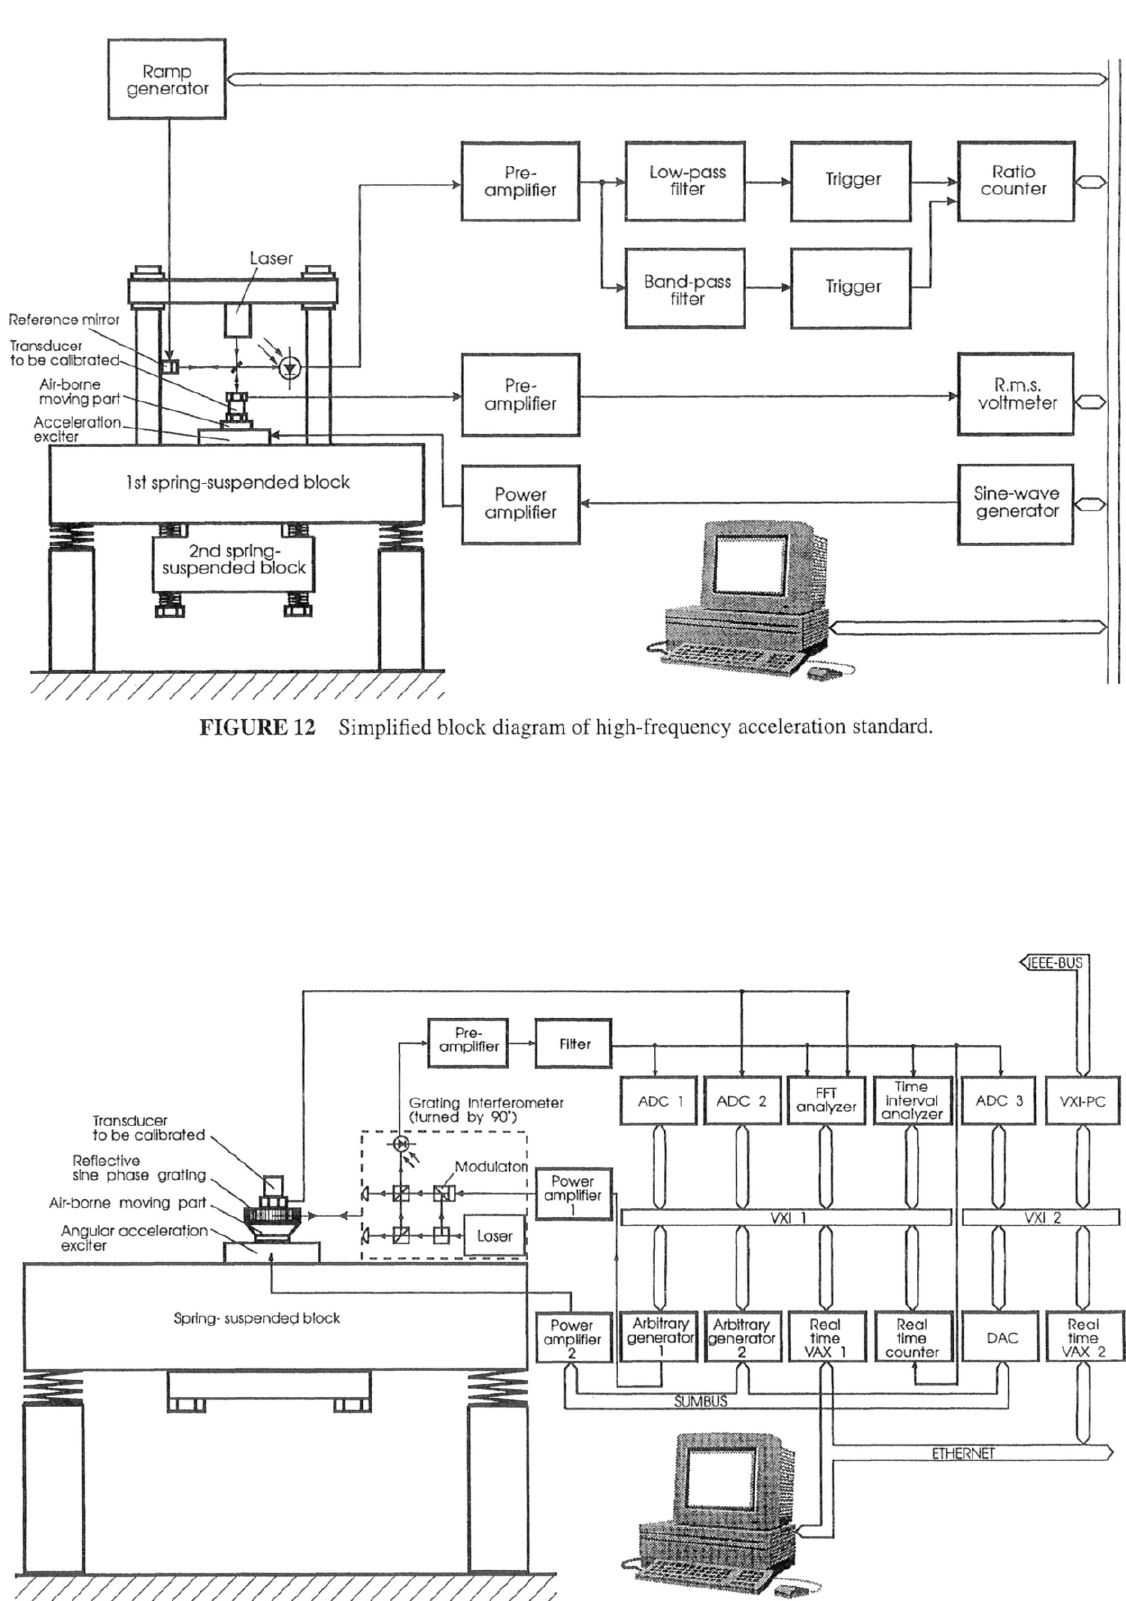
FIGURE 13 Simplified block diagram of angular acceleration